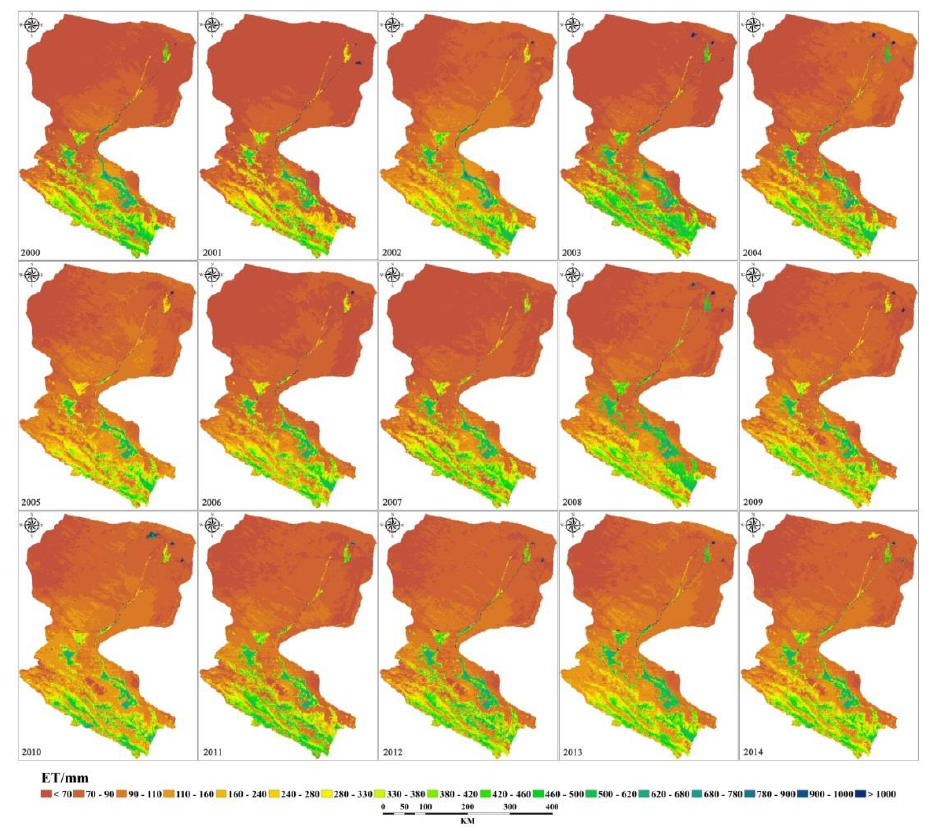
Figure 2. Annual evapotranspiration at 1 km resolution from 2000 to 2014 in the Heihe River Basin. Table 2. Annual rainfall and estimated evapotranspiration (ET) by landcover type from 2000 to 2014 for the Heihe River Basin (in mm).